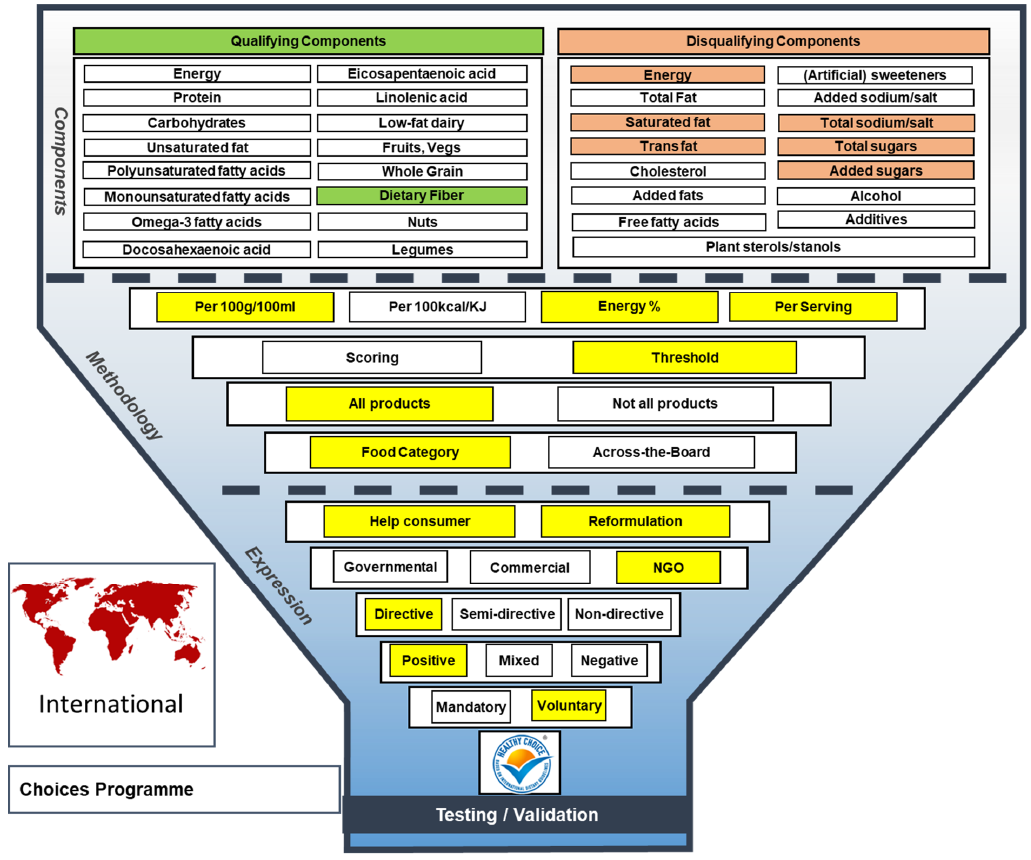
Figure 3. The Funnel Model describing functional and visual aspects of the international Choices label.